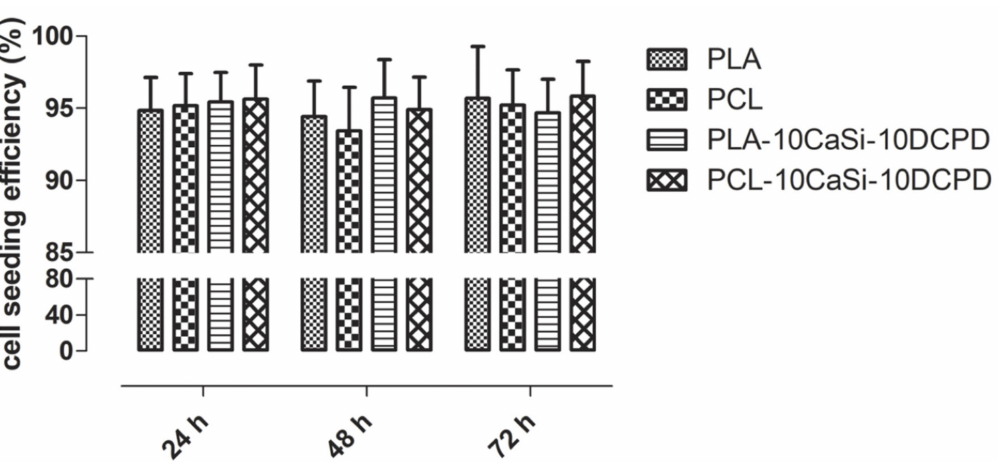
Figure 3. Cell seeding e ffi ciency performed through an indirect method. After 24 h from the seeding on the sca ff old surface, the unattached cells were quantified and cell seeding e ffi ciency was calculated by the equation: CSE (%) = (1 − cells u / cells i ) × 100. Data represent the mean ± SD of three independent biological replicates (n = 3) and were analysed using one-way ANOVA followed by the Tukey’s post hoc comparison. No di ff erences were detected among di ff erent sca ff olds.